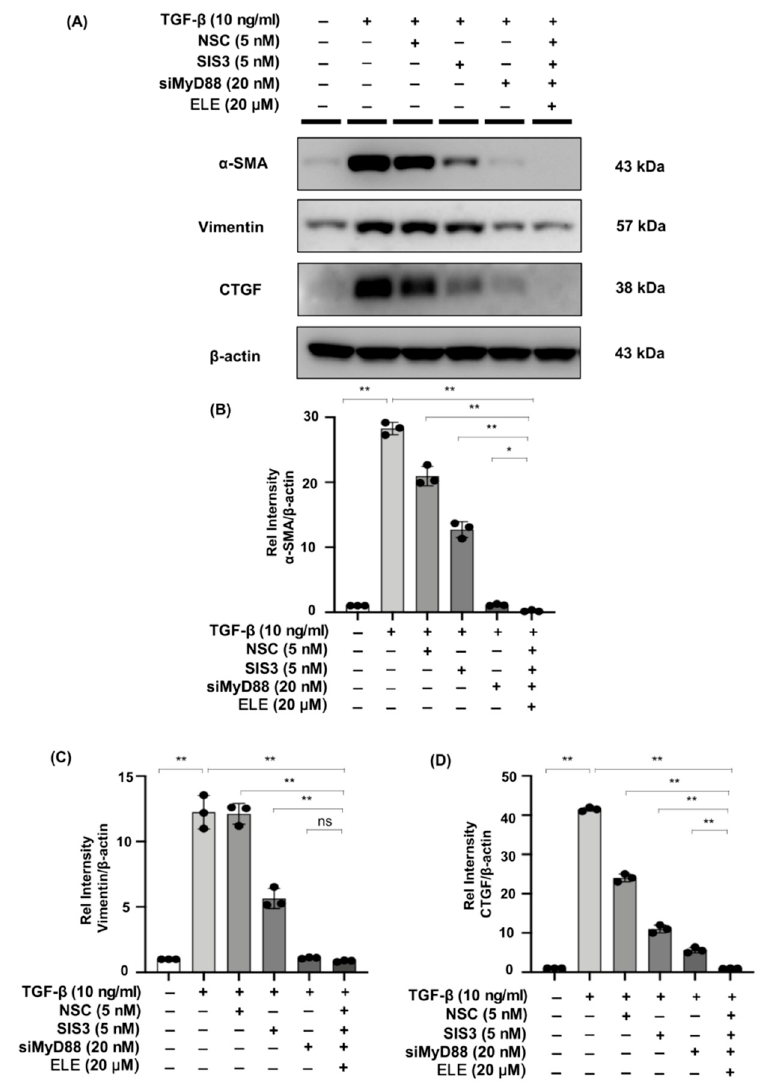
Figure 8. Co-treatment of β -elemene with specific STAT3 phosphorylation inhibitor, Smad3 phos- phorylation inhibitor, and siMyD88 effectively reduces fibrosis in TGF- β stimulated NRK49F cells. ( A ) Western blotting revealed that α -SMA, vimentin, and CTGF expression was decreased by co- treatment of β -elemene with NSC, SIS3, and siMyD88 in TGF- β stimulated NRK49F cells. NRK49F cells were treated with NSC or SIS3 for 2 h and treated with TGF- β (10 ng/mL) for 30 min, and incubated in a 5% FBS medium for 24 h; NRK49F cells were transfected with siMyD88 for 24 h in high-glucose DMEM without FBS, starved with 0.5% FBS medium, then treated with TGF- β (10 ng/mL) for 30 min, and incubated in 5% FBS medium for 24 h; NRK49F cells were transfected with siMyD88 for 24 h in high-glucose DMEM without FBS, starved with 0.5% FBS medium, and then treated with NSC, SIS3 and β -elemene for 2 h before treated with TGF- β (10 ng/mL) for 30 min, and incubated in 5% FBS medium for 24 h. ( B – D ) Statistical significance was presented as the mean ± SD, n = 3. * p < 0.05, ** p < 0.01, ns: no significance. The above results show that β -elemene treatment attenuates kidney fibrosis markers through its influence on STAT3, Smad3, and MyD88-dependent fibrotic signaling. Figure 9 is a schematic diagram illustrating the results of the present